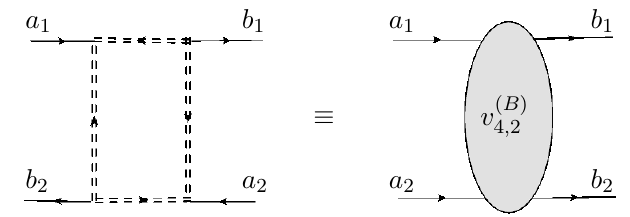
Figure 10 . The irreducible two-loop diagram in the di(cid:11)erence theory proportional to the colour tensor C ( B ) a 1 a 2 b 1 b 2 de(cid:12)ned in 4